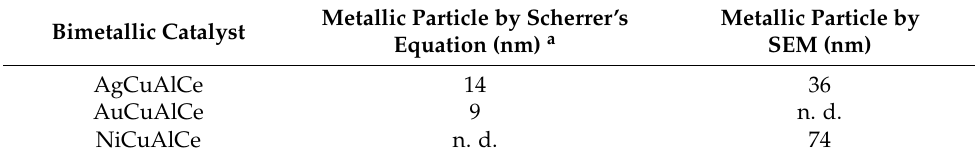
Table 2. Metallic particle size of bimetallic